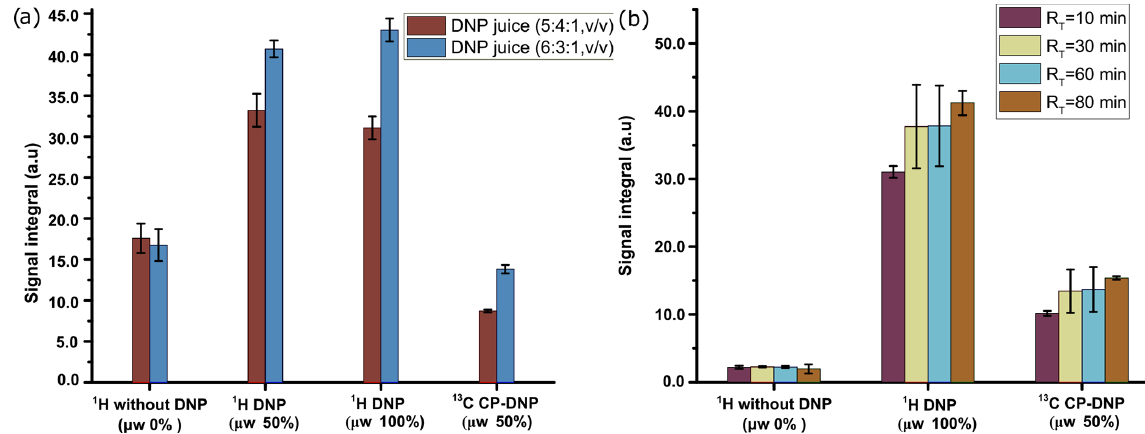
Figure 4. (a) Plot of solid-state 1 H signal without µw as well as 1 H and 13 C DNP signal integrals at two different DNP juice compositions with 50mM TEMPOL using optimized µw parameters. (b) Plot of solid-state 1 H and 13 C signal without µw as well as DNP signal integral at different ripening time with same TEMPOL concentration using optimized µw parameters. The standard deviation for every average integral value is calculated from three identical samples and displayed as an error